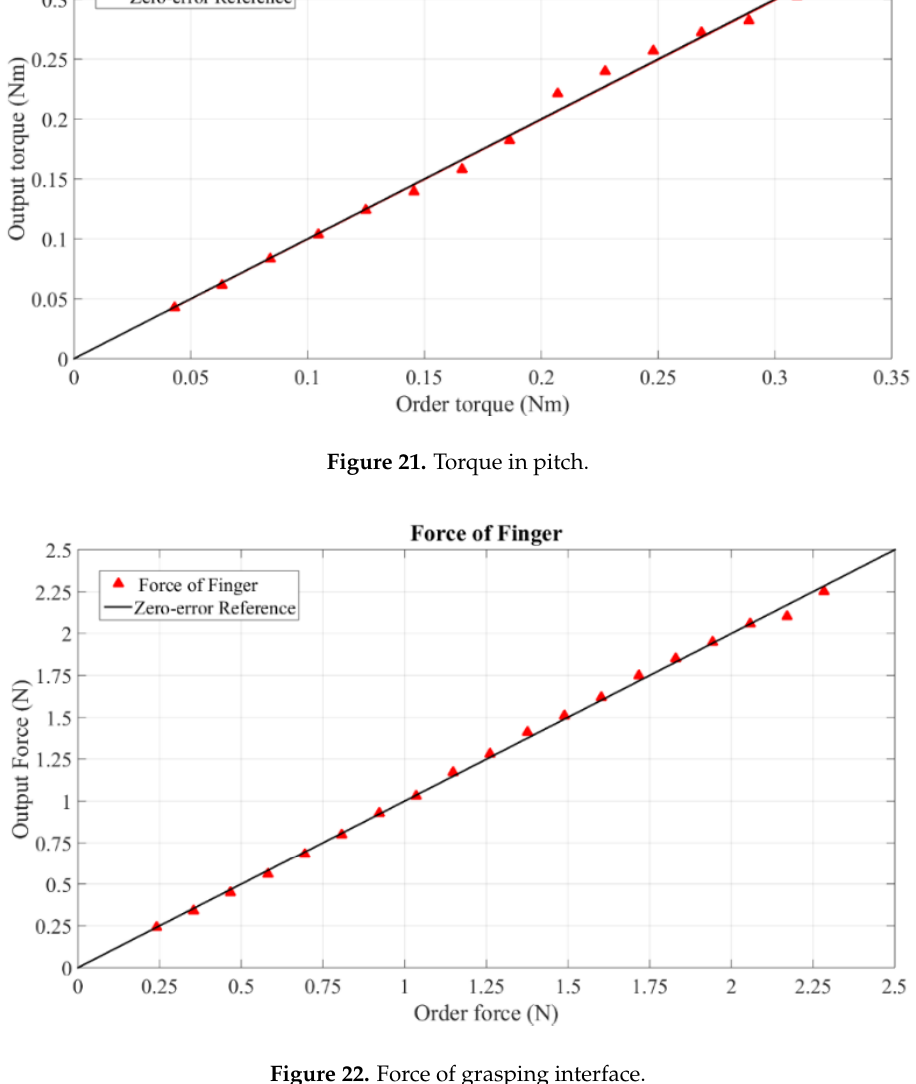
Figure 22. Force of grasping interface.